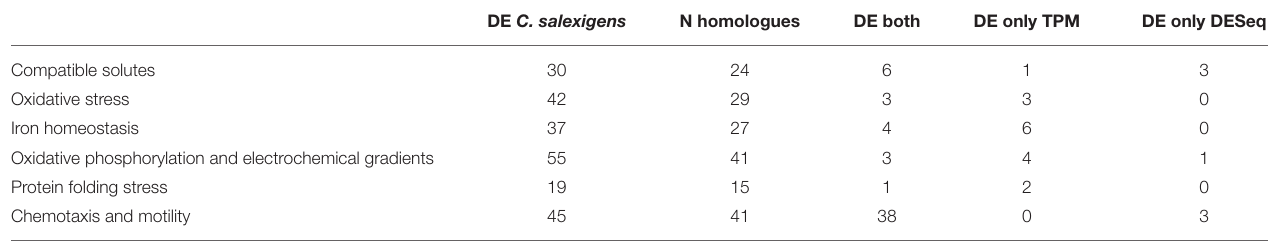
TABLE 2 | Homologues in H. elongata of the genes found differentially expressed in C. salexigens , Supplementary Tables S6 to S11 in Salvador et al.